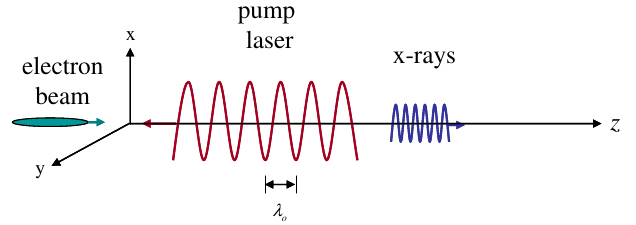
FIG. 1. (Color) Schematic of laser-pumped free-electron laser. The pump laser and electron beam propagate in opposite direc- tions along the z